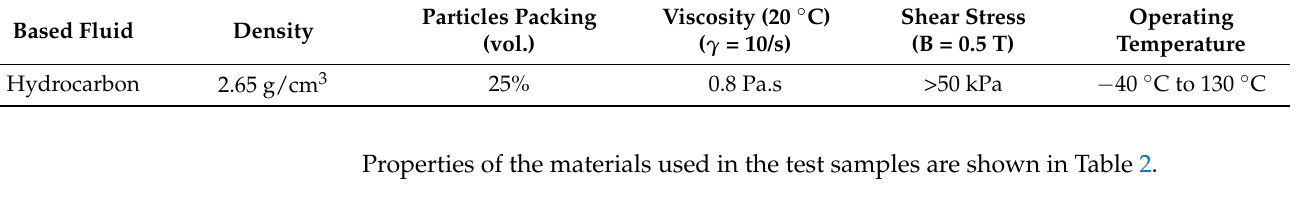
Table 2. Properties of the material used in the test samples.